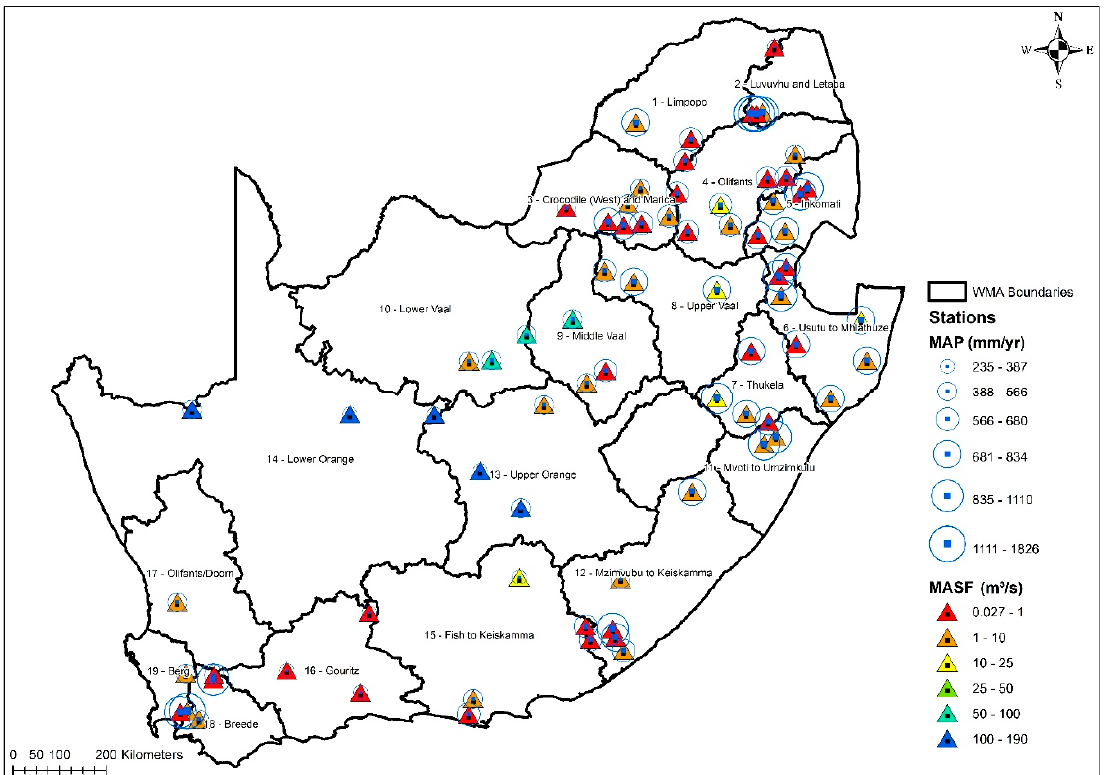
Figure 1. A map depicting the study area. The selected rainfall and streamflow stations are fairly distributed across all the 19 Water Management Areas (WMA) across South Africa. The map also depicts the mean annual precipitation and mean annual streamflow as recorded at the selected stations.